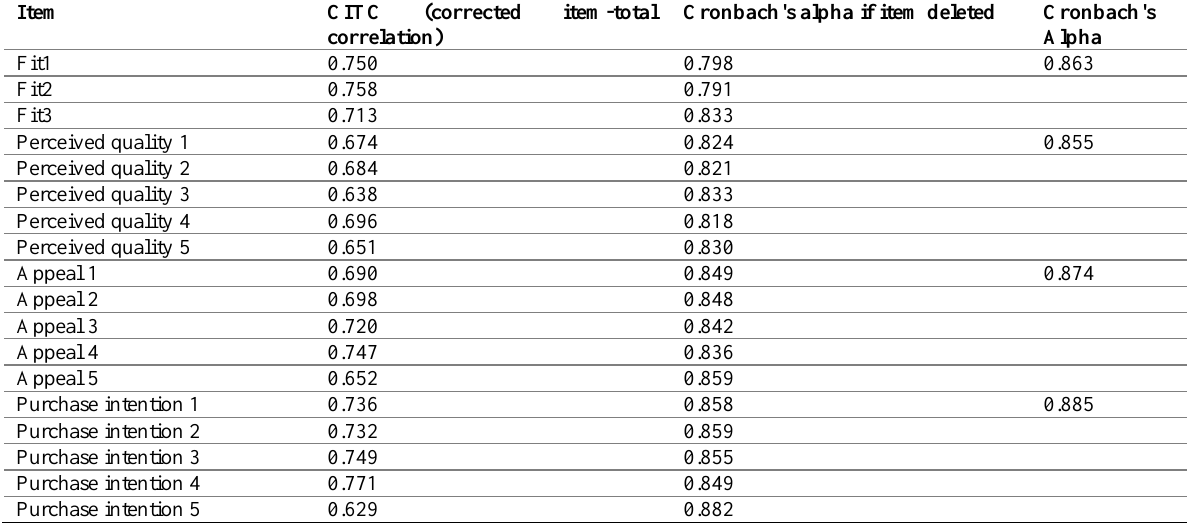
Table 3: Reliability analysis